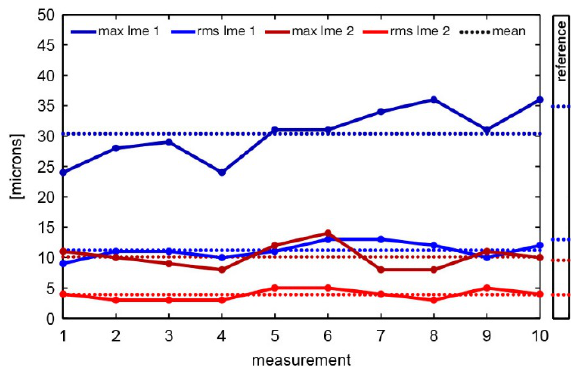
different target detector